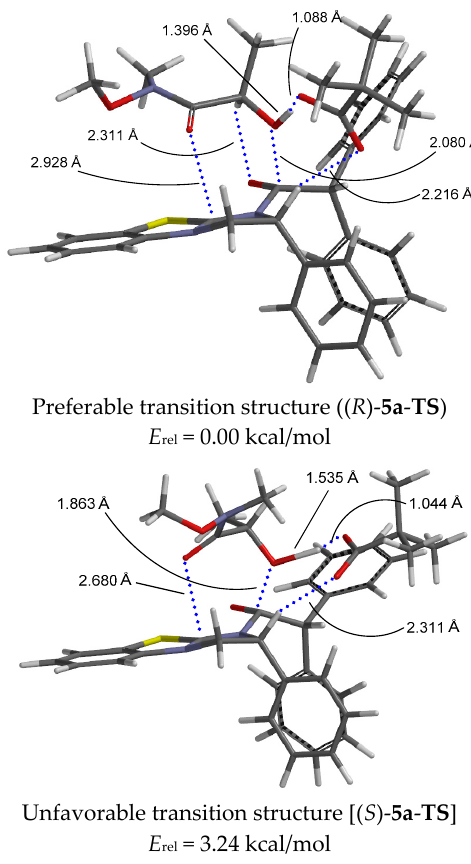
Figure 2. Three-dimensional structures of the calculated transition states (( R )- 5a - TS and ( S )- 5a - TS ). Molecules 2018 , 23 , x FOR PEER REVIEW Finally, we attempted to transform the obtained chiral 2-hydroxyamides and their esters based on the KR to demonstrate the synthetic utility of this method (Scheme 4). Reduction of chiral 2- hydroxy- N,N -dimethylamide ( S )- 1d with BH 3 ·SMe 2 in THF afforded amino alcohol ( S )- 7 in good yield with no loss of chirality (i). When 2-acyloxy- N,N -dimethylamide ( R )- 2d was subjected to solvolysis with K 2 CO 3 in MeOH, 2-hydroxyamide ( R )- 1d was produced in good yield (ii). Treatment of 2-hydroxy-Weinreb amide ( S )- 5a and 2-ayloxy-Weinreb amide ( R )- 6a with PhMgBr afforded the corresponding 2-hydroxyketone 8 with opposite stereochemistry (iii) and (iv), respectively.